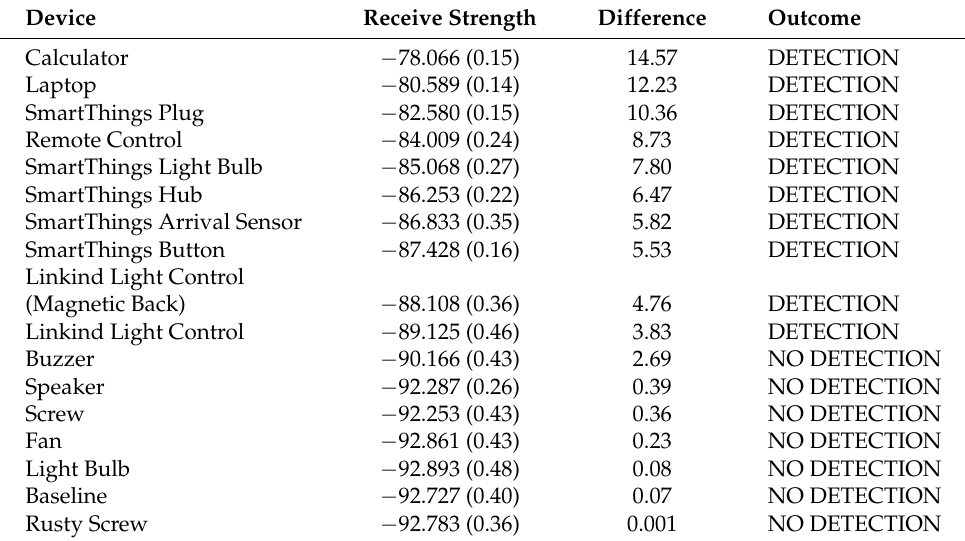
Table 2. Wireless testbed results. The average noise level (floor) was − 92.787 dBm with a standard deviation of 0.406 dB. Each measurement is an average of 15 readings with standard deviation shown in